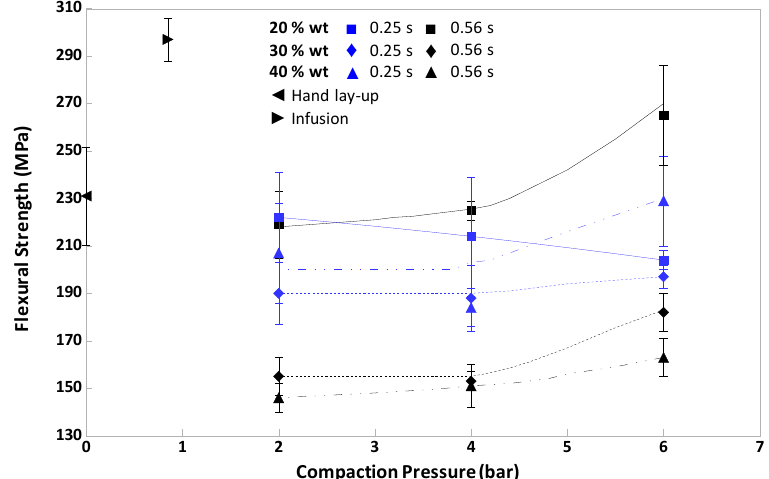
Figure 18. Flexural strength of the composites with prepreg fibre contents of 20 ( ■ ), 30 ( ♦ ), and 40 wt.% ( ▲ ) and an initial exposure time of 0.56 s, and those with prepreg fibre contents of 20 ( ■ ), 30 ( ♦ ), and 40 wt.% ( ▲ ) and an initial exposure time of 0.25 s vs. the compaction pressure.